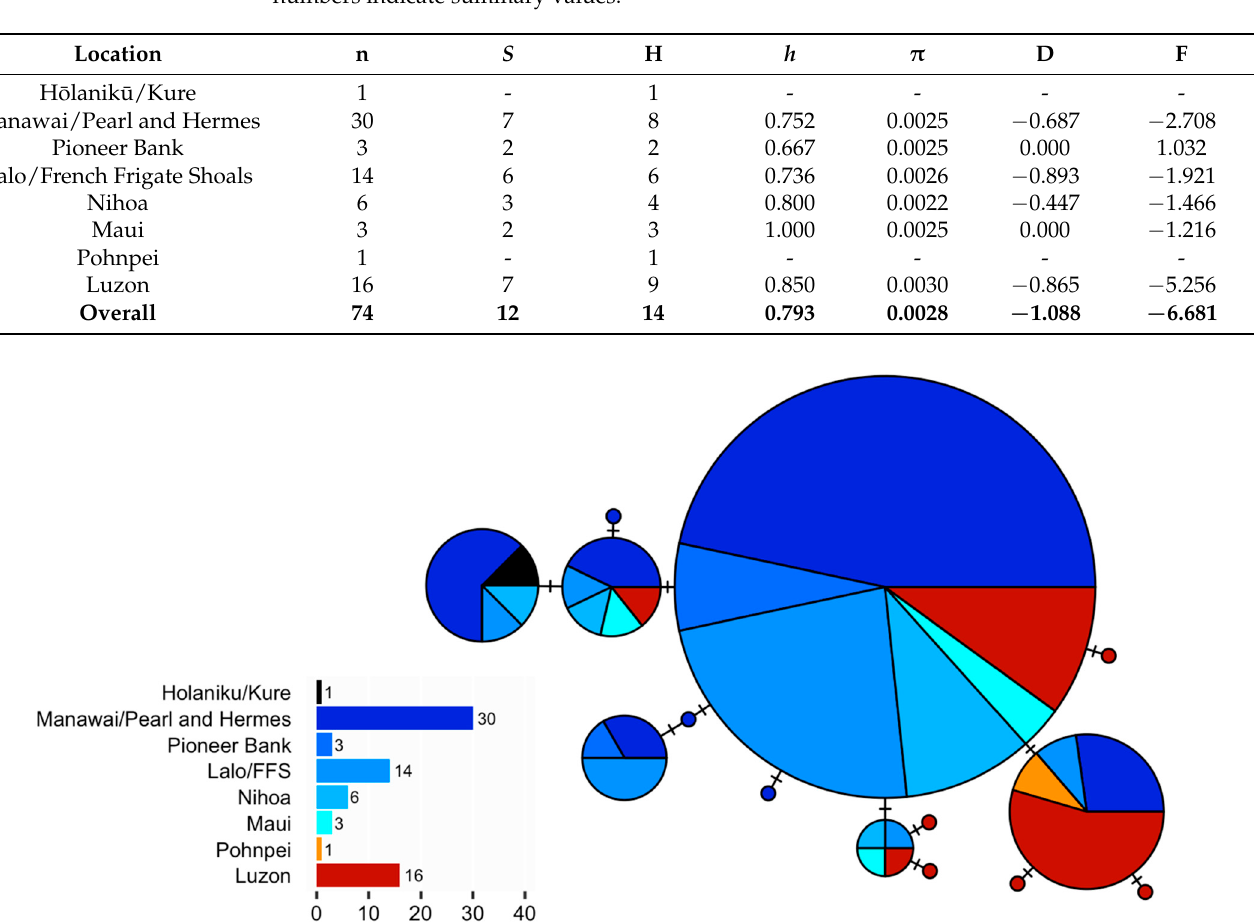
Table 2. Population genetic diversity summary statistics for Neoniphon aurolineatus across all sampling locations (n = number of samples sequenced, S = number of segregating sites, H = number of unique haplotypes, h = haplotype diversity, π = nucleotide diversity, D = Tajima’s D, F = Fu’s F). Bold numbers indicate summary values.